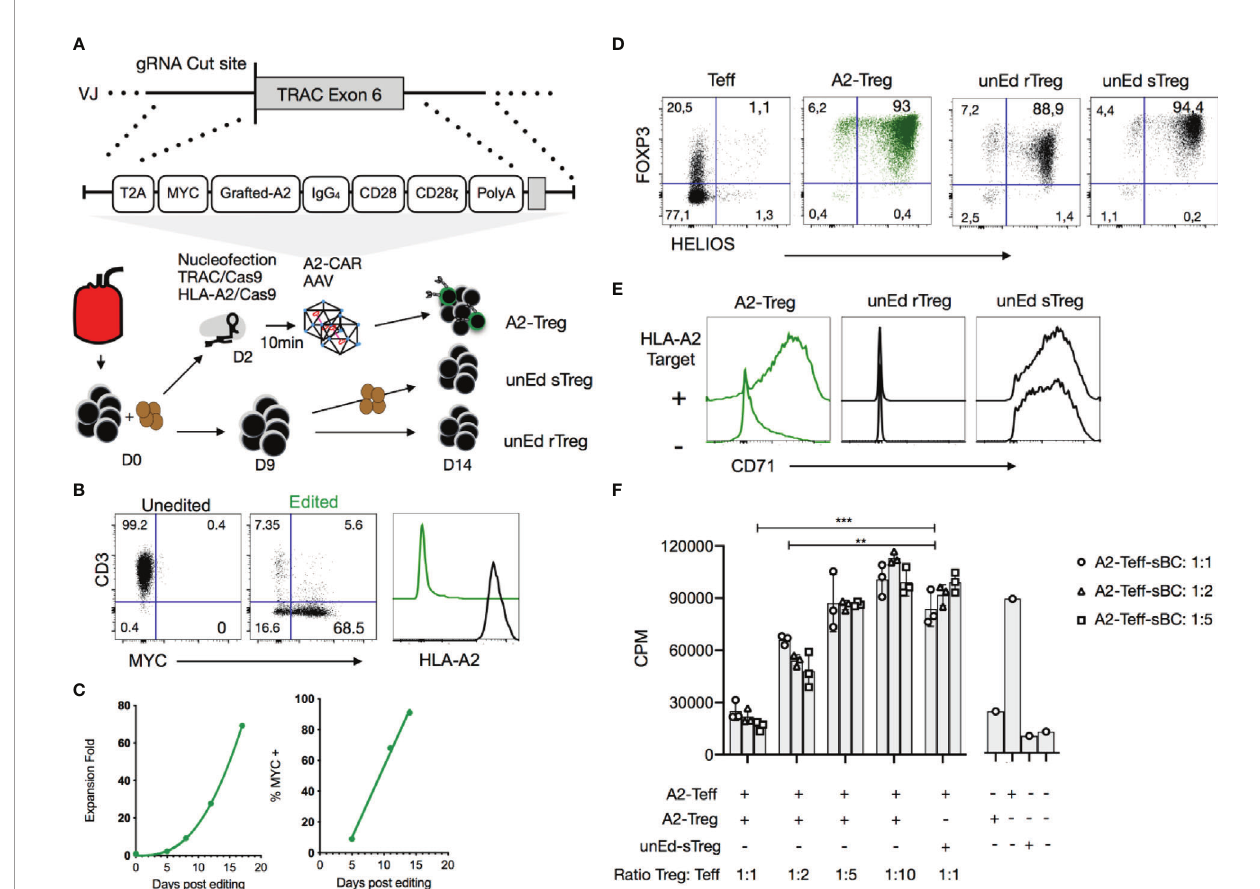
FIGURE 4 | Precision engineering of an A2-CAR into the TRAC locus of human Tregs. (A) Expansion strategy of A2-CAR Tregs, unedited resting Tregs (unEd rTreg) and unedited stimulated Tregs after sorting from peripheral blood of an HLA-A2 positive donor. For homology-directed repair-mediated integration into the TRAC locus, the A2-CAR template was inserted using AAV6 transduction after electroporation of two CRISPR/Cas9 ribonucleoprotein (RNP) complexes targeting the TRAC and HLA- A loci. (B) Representative fl ow cytometry of the editing ef fi ciency measured 10 days later in 3 independent experiments. CD3, MYC-tag, and HLA-A2 surface expression is shown. (C) Treg fold-expansion and percentage of MYC-tag + Tregs over time. Fitted line plots are shown. (D) Fourteen days after activation, FOXP3 and HELIOS expression were assessed on edited Tregs and compared to that of unedited T cells and unedited Day 9 stimulated Tregs (unEd sTregs). (E) The same cells were co-cocultured with or without irradiated (4000 rad) HLA-A2 + NALM6 cells. CD71 expression was assessed 48 hours later. (F) In vitro suppression assays were performed using HLA-A2 + stimulated B cells (sBCs) as stimulator cells, A2-CAR + TCR de fi cient CD4 + T cells as responder cells (0.05 x 10 6 cell/96well) and A2-CAR + TCR de fi cient Tregs at different ratios. After 3 days, 0.5 m Ci/well of 3 [H] thymidine (Perkin Elmer, Waltham, MA) was added for the fi nal 16 h of culture. Proliferation was assessed by 3 [H] thymidine incorporation (counts per minute - cpm). Two-way ANOVA was used to determine the statistical signi fi cance of the difference. Data corresponds to the cells infused in Figure 5 . Similar results were obtained with 3 independent donors. ** p < 0.01; ***p < 0.001. Teff, CD4 + T effector cells; A2-Treg, A2-CAR + TCR de fi cient Treg; unEd sTreg, unedited Day 9 stimulated Tregs; A2-Teff, A2-CAR + TCR de fi cient Teff; sBC, stimulated B cells; CPM, counts per minute